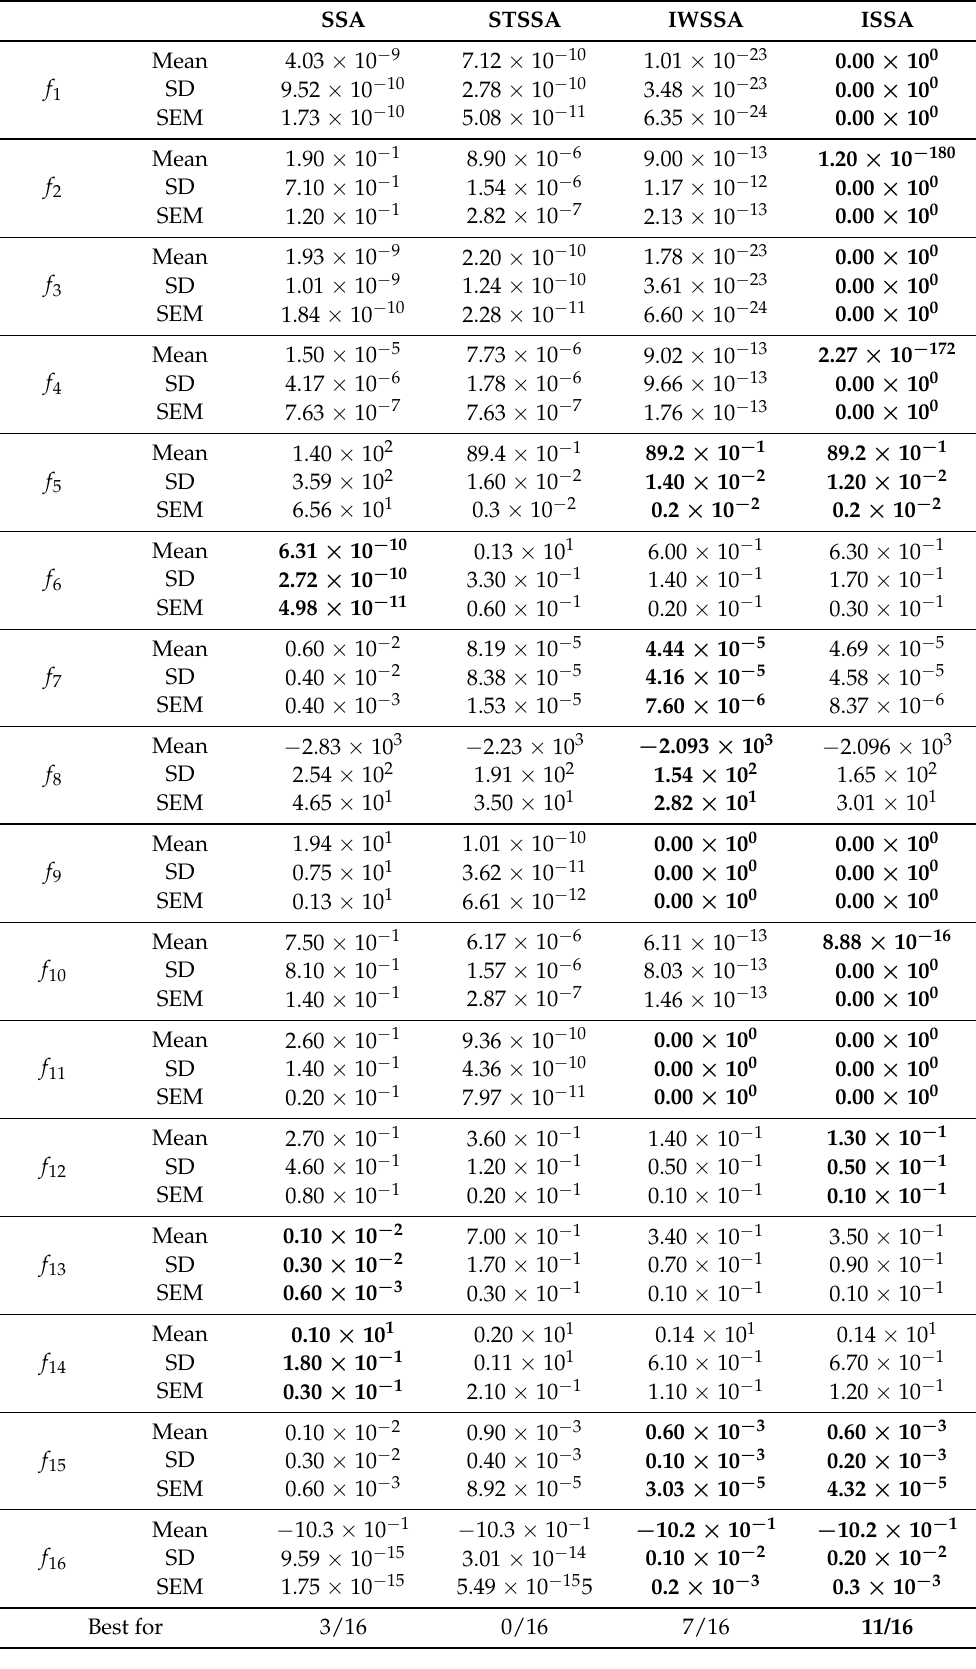
Table 1. Mean, SEM, and SD for functions f 1 − f 16 obtained by SSA, STSSA, IWSSA, and